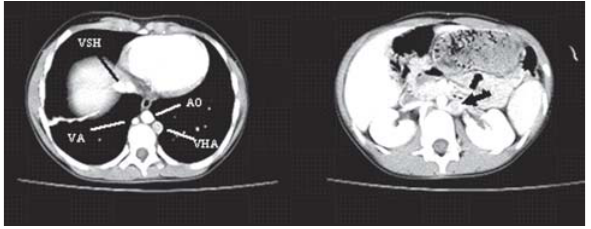
Fig. 2 - Veia ázigos (VA) e veia hemi-ázigos (VHA) dilatadas; veias supra-hepáticas (VSH) e aorta (AO); sistema ázigos dilatado (seta), posicionado à esquerda da aorta, drenando as veias renais